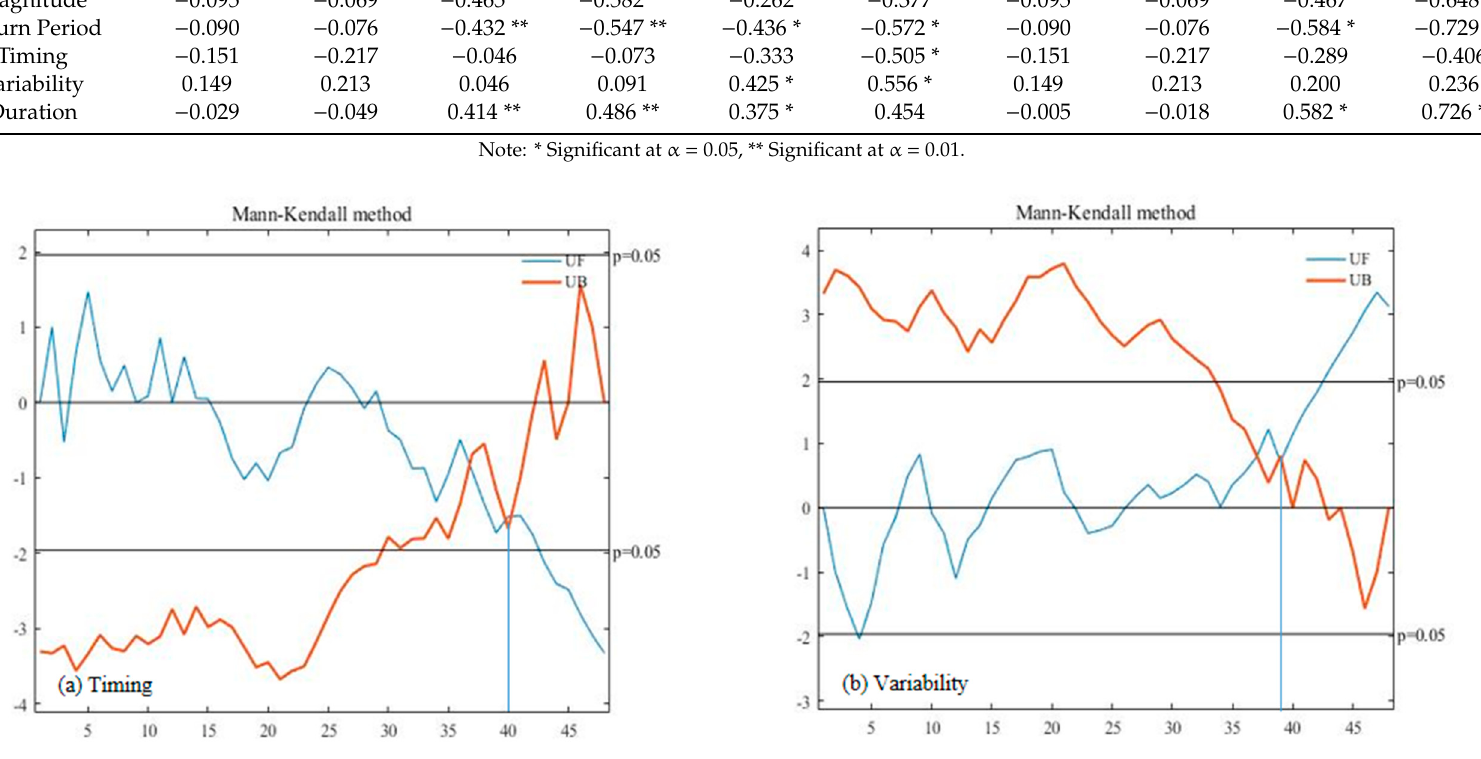
Figure 3. Mann–Kendall breakpoint tests for ( a ) timing and ( b ) variability of low flows from 1959 to 2006. Table 6. Change point test in low flow regime components from 1959 to 2006.